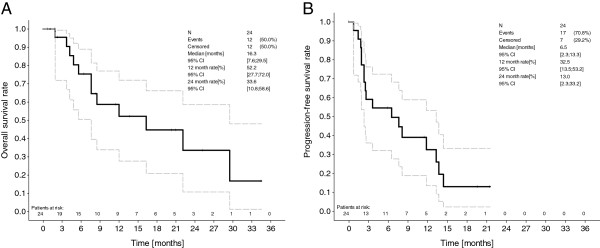
Kaplan Meier overall survival (A) and progression-free survival (B) in dose levels 1–3.